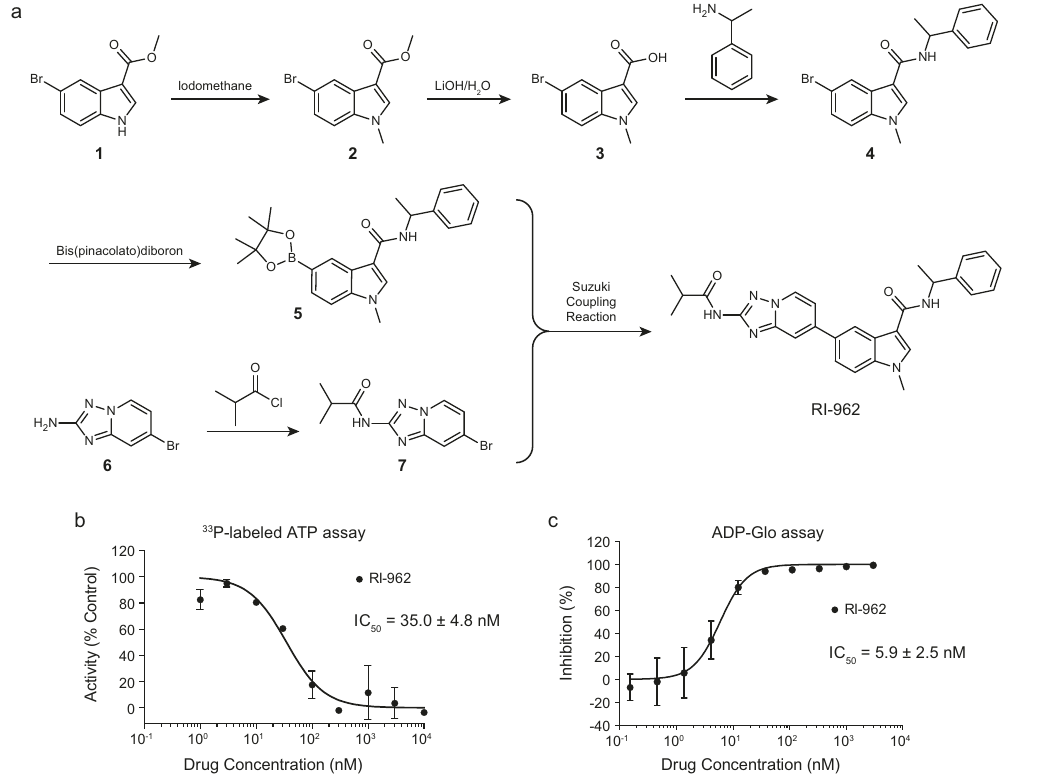
Fig. 5 | The synthetic route and enzymatic activity of RI-962. a The chemical structure and synthetic route of RI-962. b , c Dose-activity curves of RI-962 in the RIPK1 kinase assay: b 33 P-labeled ATP assay at Euro fi ns ( n =2); c ADP-Glo assay ( n =2). Data are presented as mean±standard